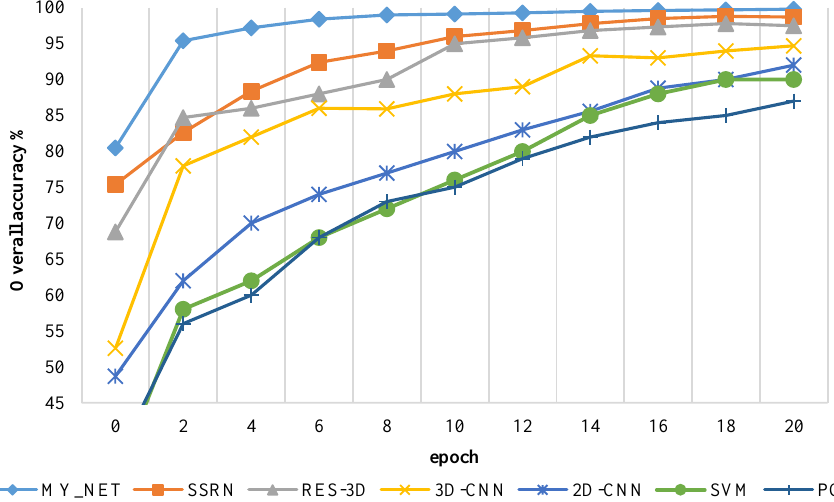
Figure 12. Overall accuracy curve of different models in Pavia University dataset. Table 4. Classification results of different models in Pavia University.